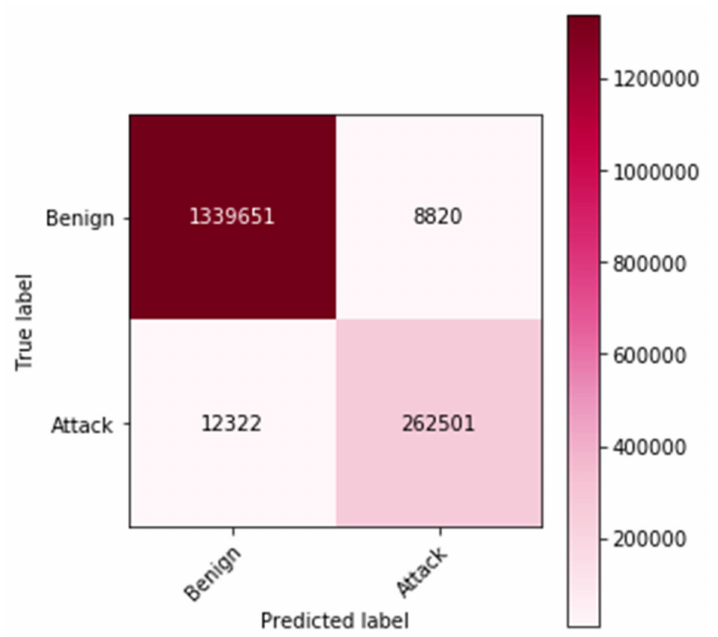
Figure 6. Confusion matrix without